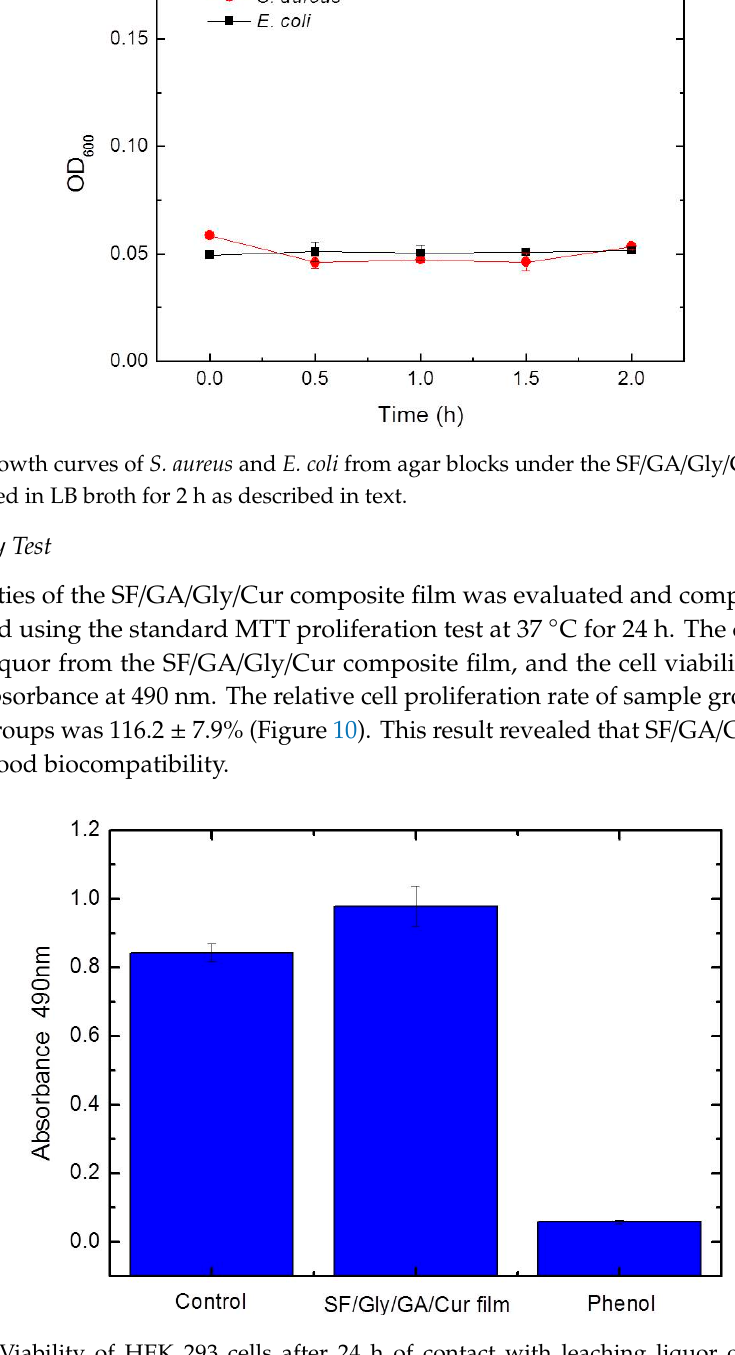
Figure 10. Viability of HEK 293 cells after 24 h of contact with leaching liquor obtained from SF / GA / Gly / Cur composite film, and revealed increased cell viability compared to control. The error bars denote the standard error of the mean ( n = 3).